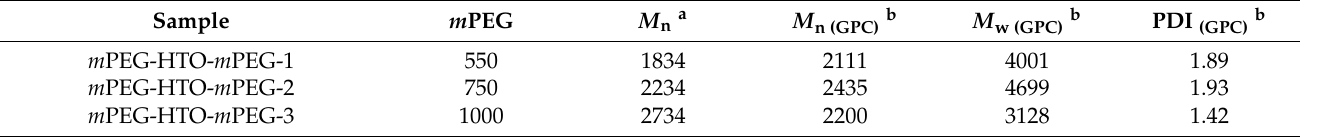
Table 1. The molecular weights and molecular weight distributions of m PEG-HTO- m PEG